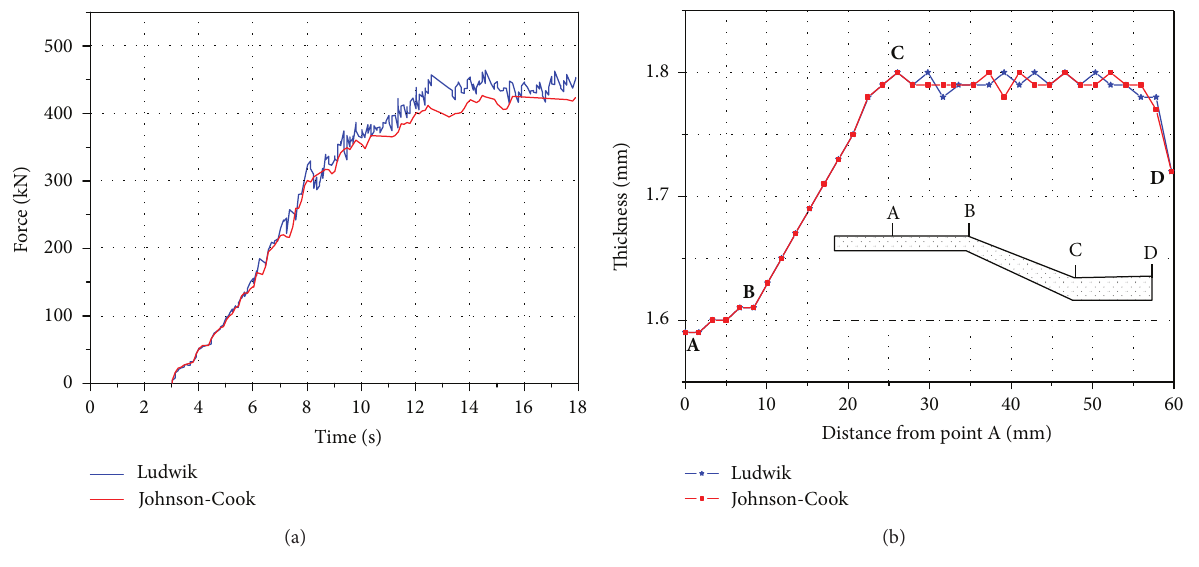
Figure 4: Numerically predicted forging force and